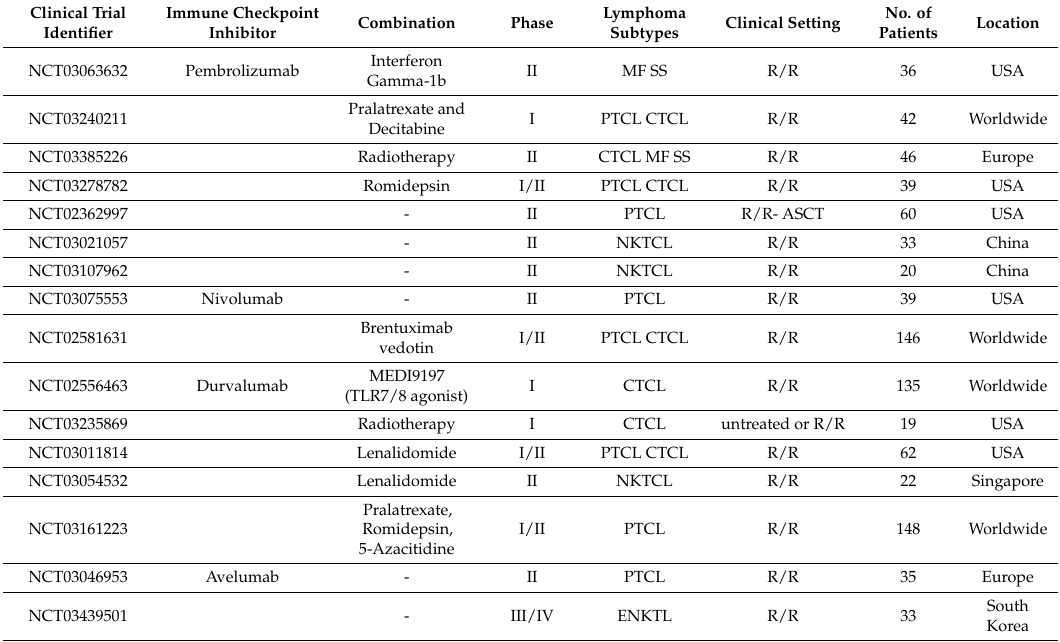
Table 3. Open clinical trials of immune checkpoint agents in